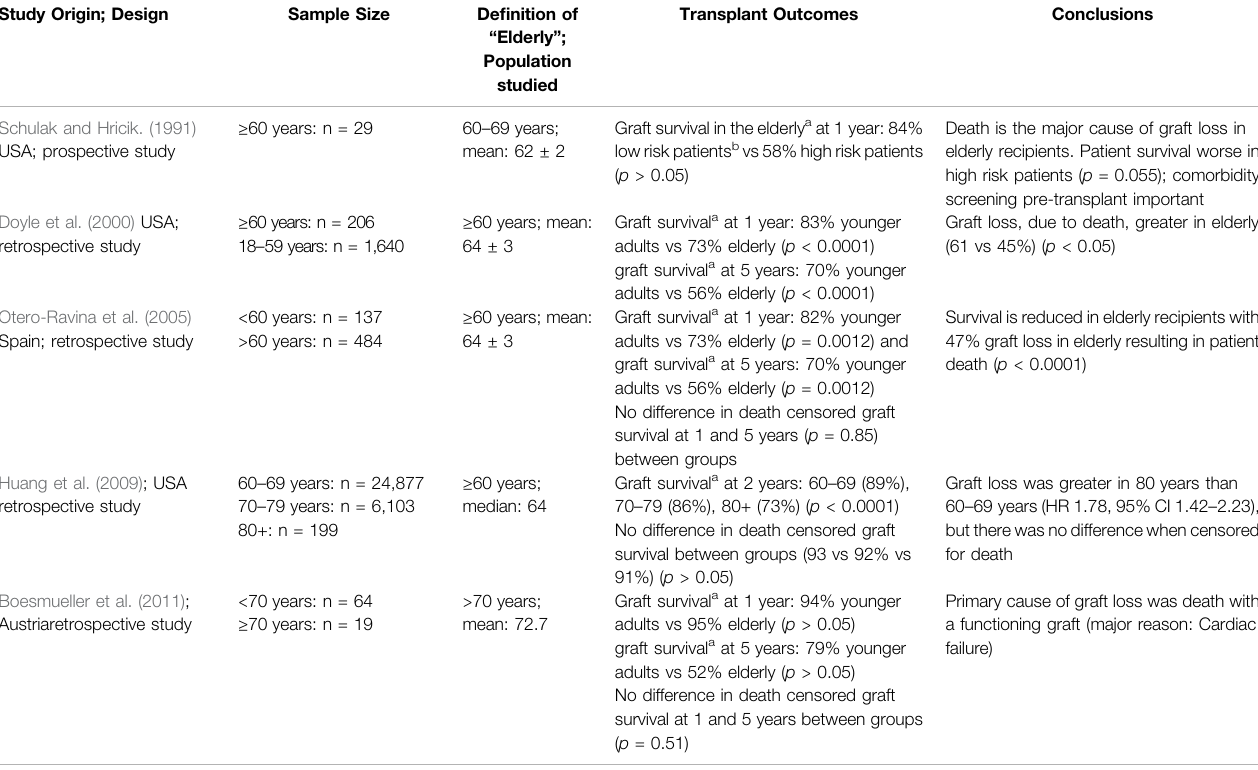
TABLE 2 | A summary of studies examining graft survival in elderly renal transplant recipients. Study Origin;